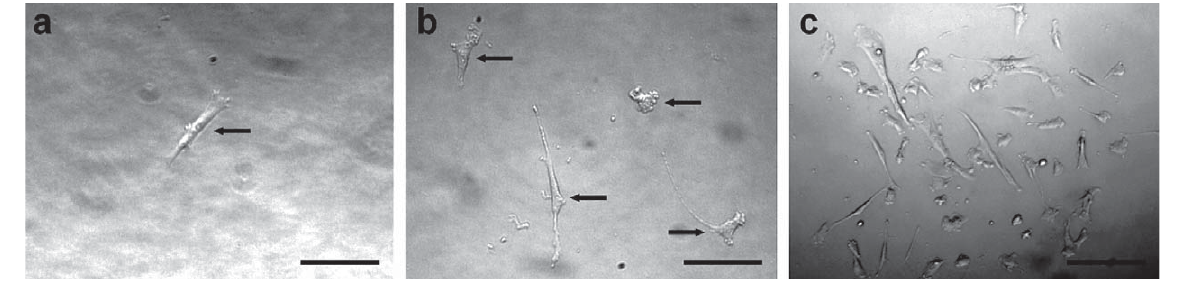
Fig. 7. Clonogenicity assay in vitro using NSTS-11 cell line. During two weeks of cultivation, single isolated cells (7a) were able to proliferate (7b) and to form colonies containing more than 50 cells (7c). Bars, 100 (cid:1) m (a, b), 200 (cid:1) m (c).